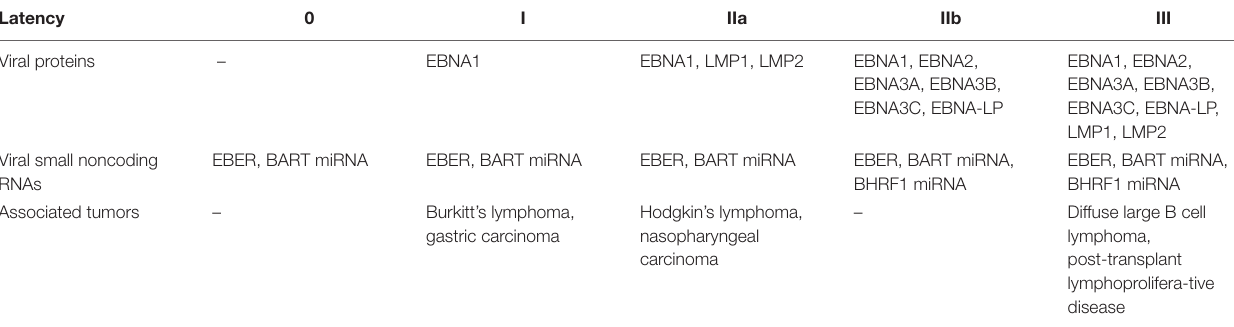
TABLE 1 | EBV latency patterns.